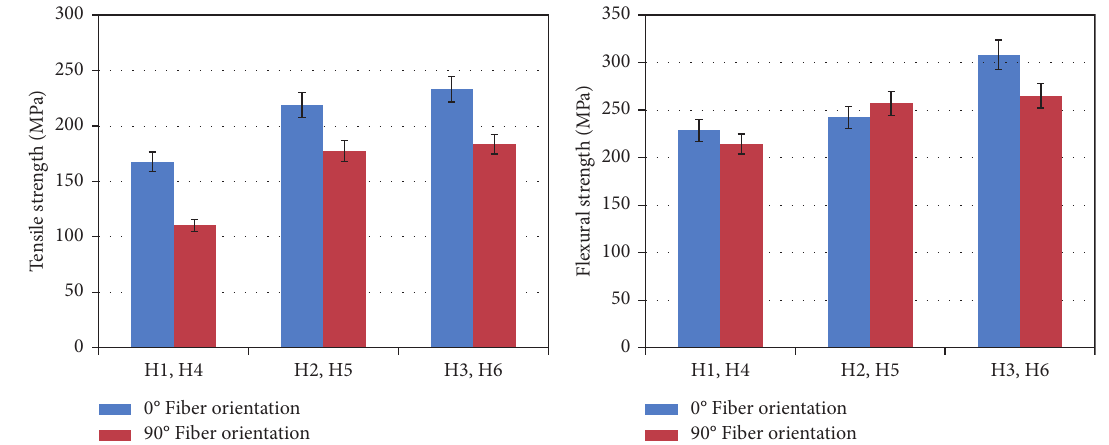
Figure 2: Effect of fibre direction on tensile and flexural strength of sisal/jute/glass fibre hybrid composite